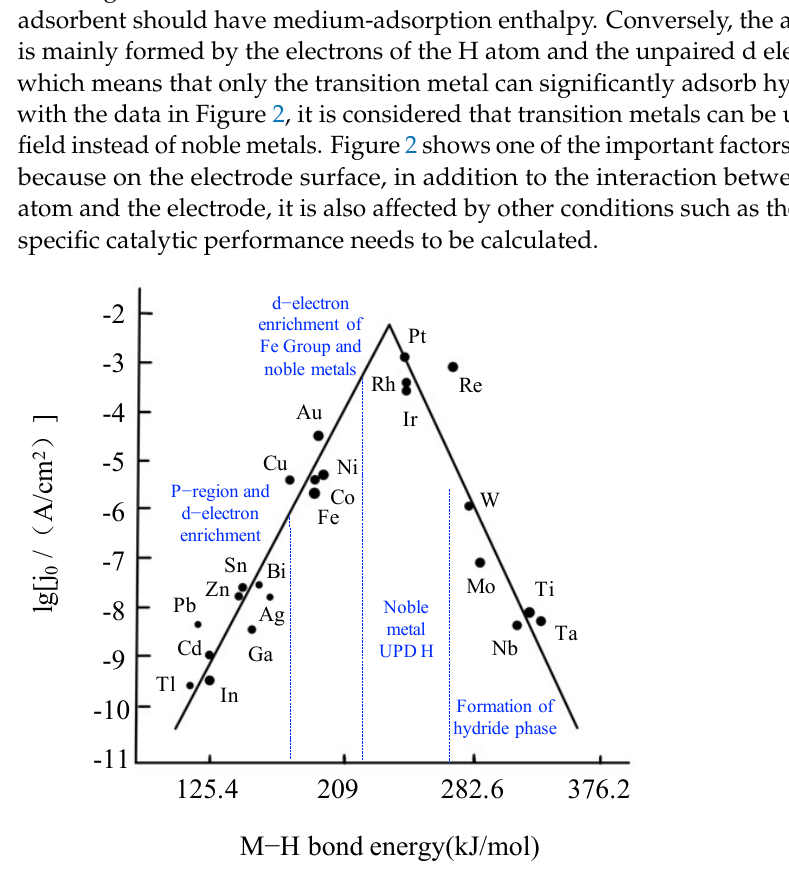
Figure 2. Volcanic formation relationship between exchange current density and M-H bond strength of the hydrogen evolution reaction on different metals.